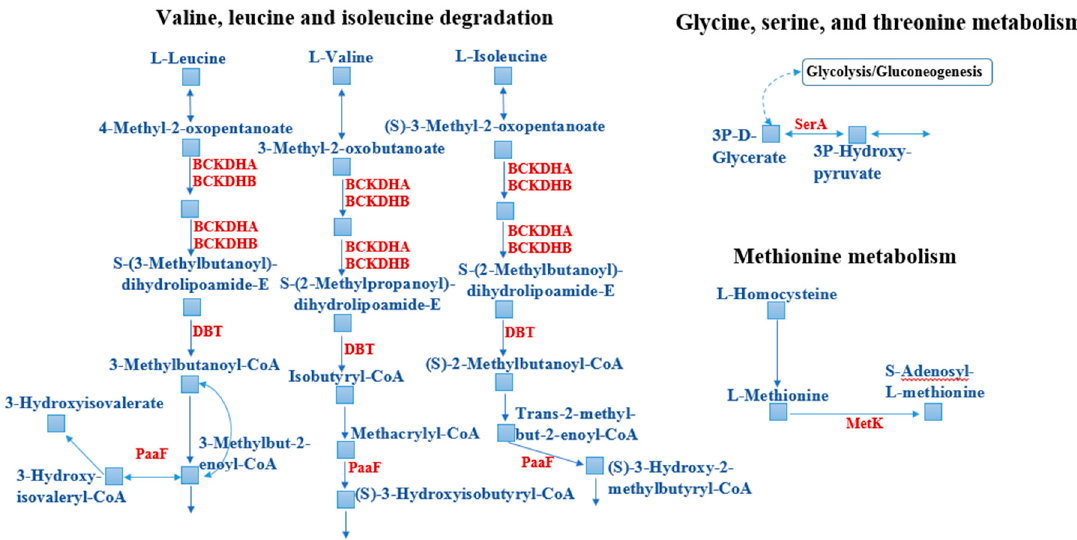
Figure 4. Upregulation of the components of the amino acid metabolism in Sb. thermotolerans in response to the gold-bearing pyrite-arsenopyrite concentrate. PaaF: Enoyl-CoA hydratase [EC 4.2.1.17]; DBT: 2-Oxoisovalerate dehydrogenase E2 component (dihydrolipoyl transacylase) [EC 2.3.1.168]; BCKDHB: 2-Oxoisovalerate dehydrogenase E1 component beta subunit [EC 1.2.4.4]; BCKDHA: 2-Oxoisovalerate dehydrogenase E1 component alpha subunit [EC 1.2.4.4]; MetK: S-adenosylmethionine synthetase [EC 2.5.1.6]; SerA: D-3-phosphoglycerate dehydrogenase / 2-oxoglutarate reductase [EC 1.1.1.95 1.1.1.399]. Substrates, intermediates, and products are indicated in blue and upregulated enzymes are indicated in red.